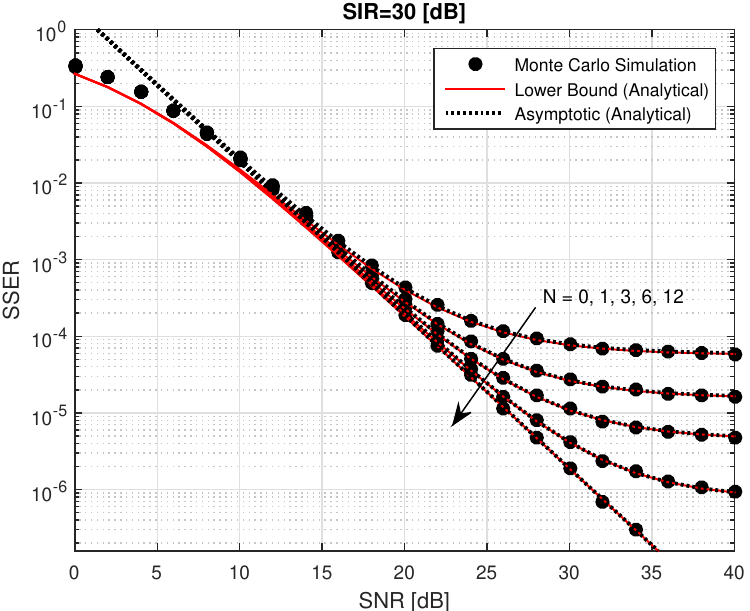
Figure 7. Sum SER performance of AF-TWRN with CCI for different number of interference signals, L 1 = L 2 =